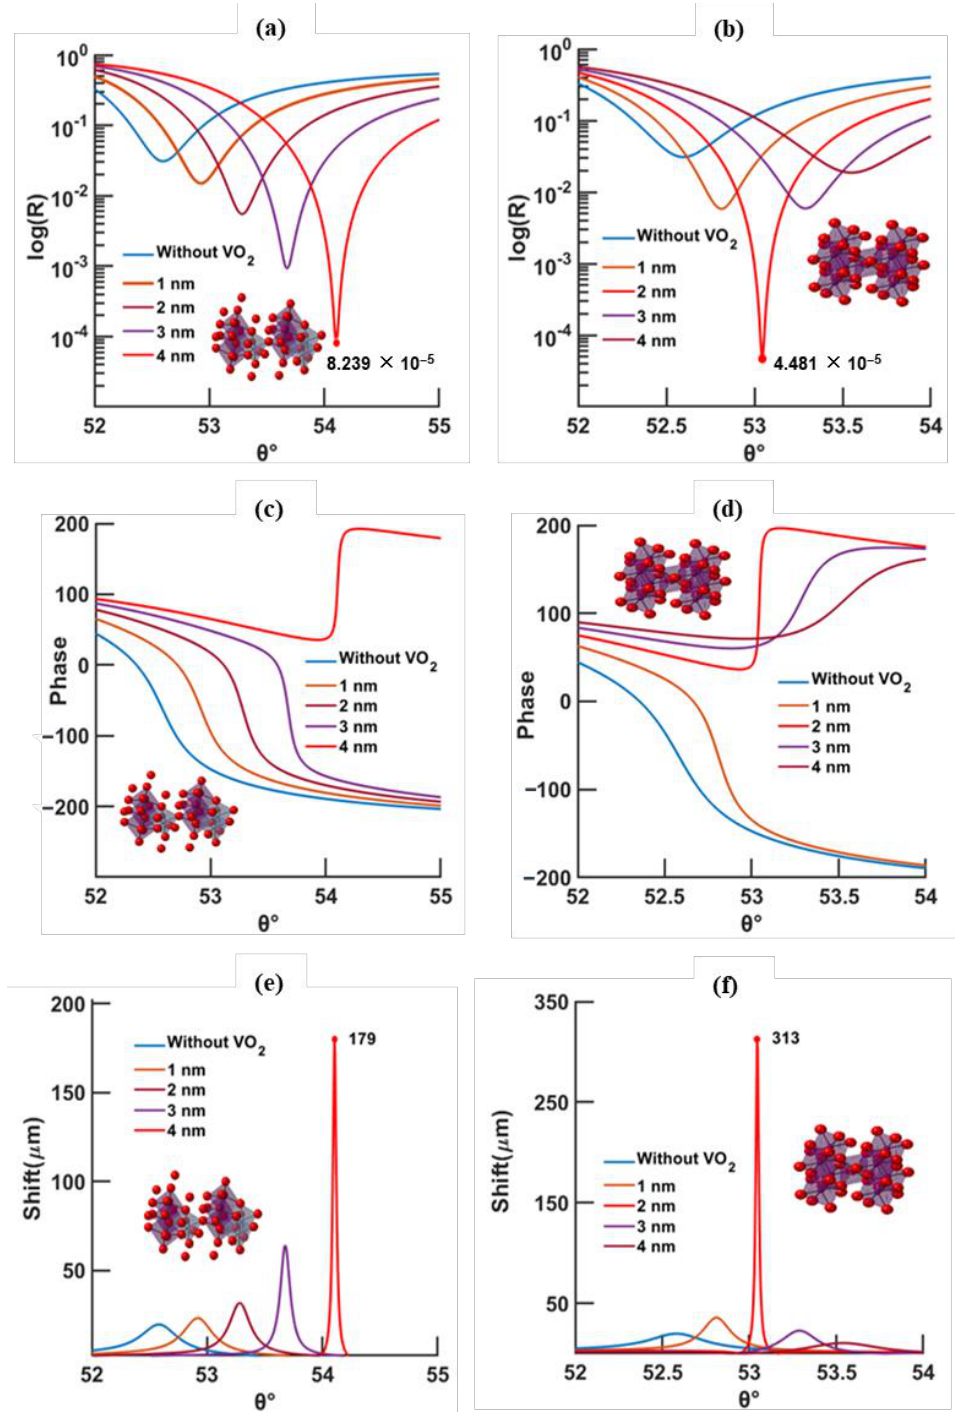
Figure 4. SPR curves with respect to the thickness of VO 2 calculated by TMM model, for an excitation of 785 nm, VO 2 temperature of 20 °C (left) and 95 ° C (right), and a gold thickness of 46 nm; ( a , b ) reflectivity, ( c , d ) phase, and ( e , f ) Goos – Hänchen shift (absolute value).